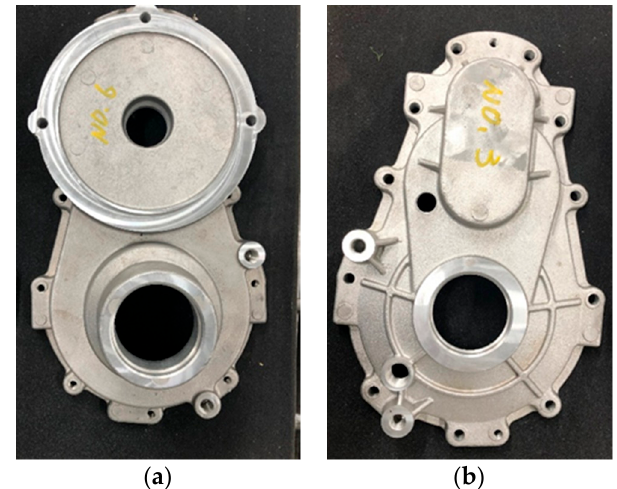
Figure 5. Components of the gearbox housing. ( a ) Upper case; ( b ) Lower case. Table 3. Updated material properties.